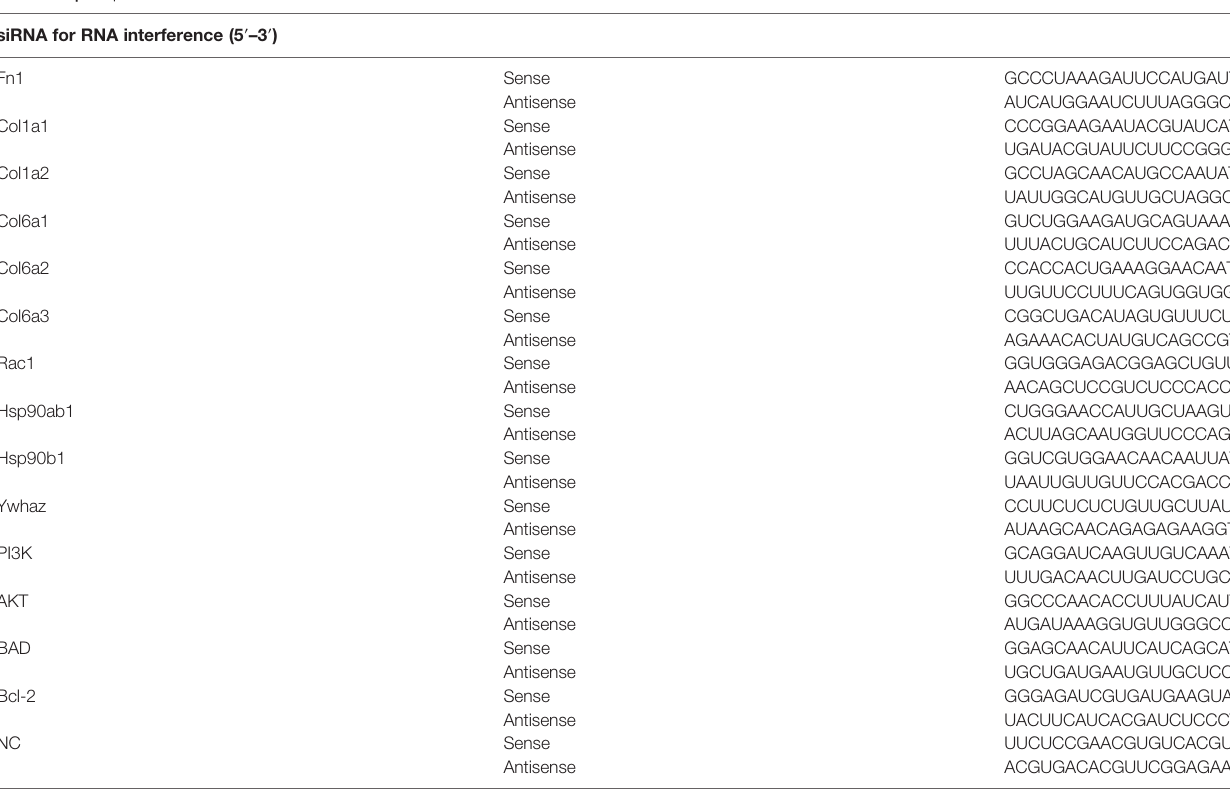
TABLE 1 | Sequences of siRNA used in RNA interference. siRNA for RNA interference (5 ′ – 3 ′ )